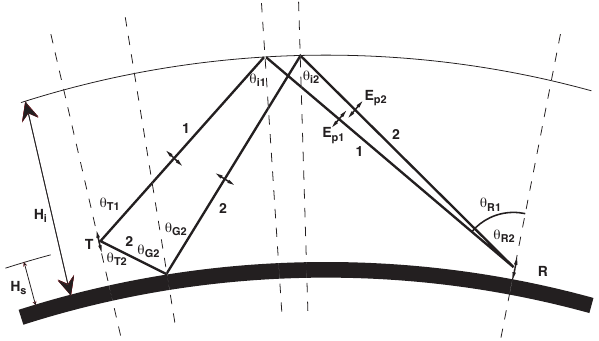
Fig. 1. Schematic of the ionospheric-reflection model. A “trans- mitter” T (in this case an intracloud lightning discharge at height H s ) radiates both a ground wave (not shown) and two ionospheric echoes. The first of these echoes departs T along an upward take-off angle directly to the ionosphere at height H i . The second departs T along a downward takeoff angle to the ground, where it is reflected toward the ionosphere. A ground-based receiver R records all three signals, including the two echoes shown here, plus the ground wave (not